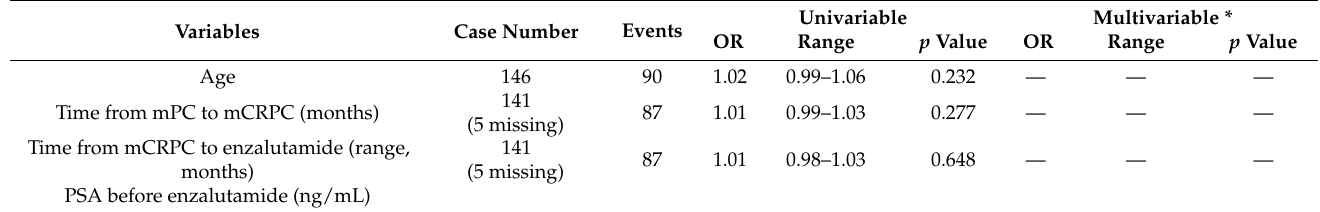
Figure 2. PSA response in the patients stratified tumor burden. PSA response defined the maximal PSA drop percentage after the use of enzalutamide. PSA drop more than 80% was referred as the good PSA response. Table 2. Univariable and multivariable analyses of PSA response to enzalutamide in metastatic castration-resistant prostate cancer patients